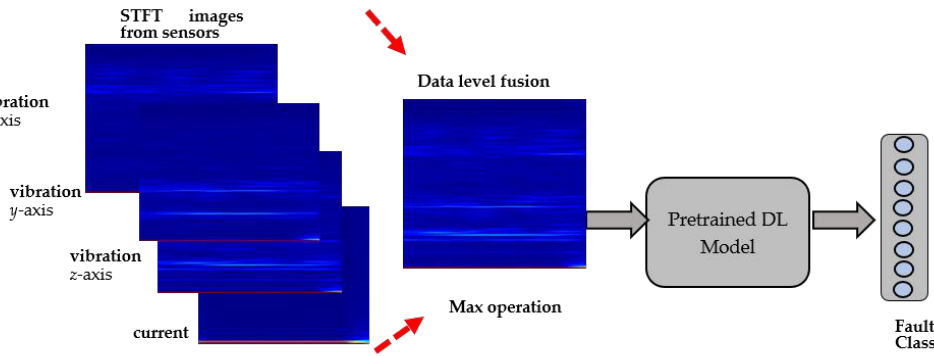
Figure 3. An illustrative figure representing the proposed sensor fusion